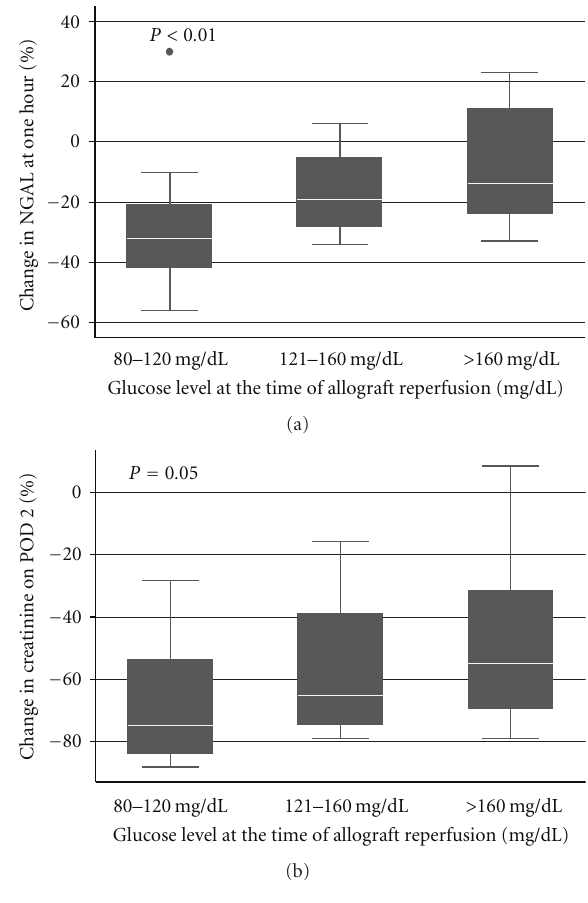
Figure 2: (a) Percentage change in NGAL levels at one hour by clinically defined glucose level (80–120 mg/dL, n = 15; 121– 160 mg/dL, n = 14; and > 160 mg/dL, n = 10) at the time of allograft reperfusion. (b) Percentage change in creatinine on POD 2 by clinically defined glucose level (80–120 mg/dL, n = 15; 121– 160 mg/dL, n = 14; and > 160 mg/dL, n = 10) at the time of allograft reperfusion. Statistical significance determined by analysis of variance. Whiskers span the 5th and 95th percentiles of all data. Dots represent